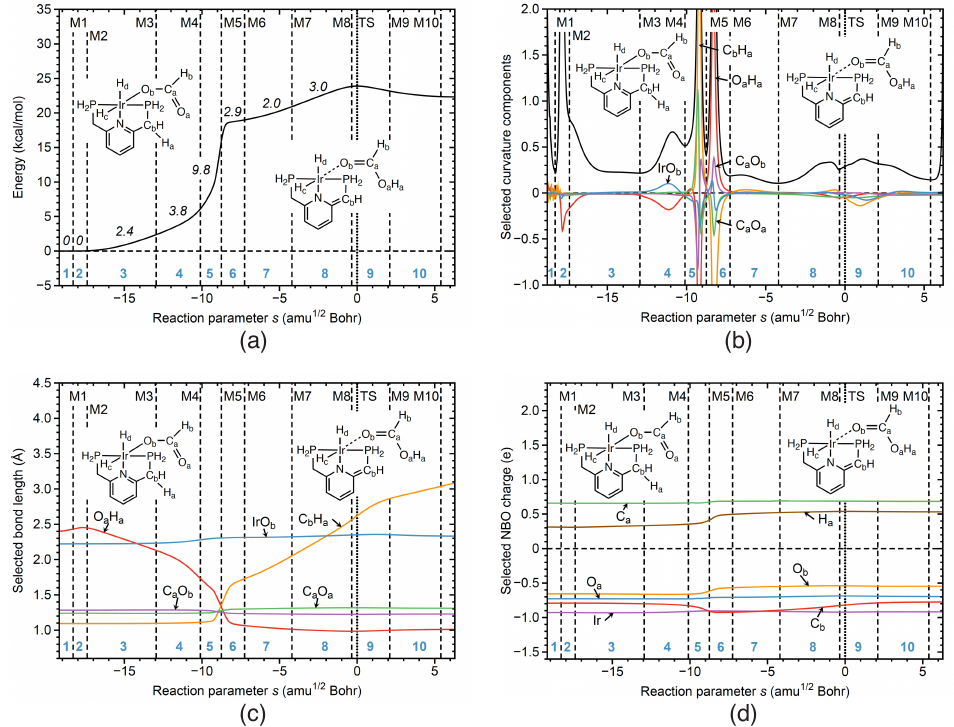
Figure 6. Properties of reaction R2 of the catalytic cycle along the reaction path. ( a ) Energy profile, energy contributions of each reaction phase to the activation energy are indicated by italic numbers; ( b ) decomposition of the reaction curvature into selected components; ( c ) change of selected bond lengths along s ; ( d ) change of selected NBO atomic charges along s . Positions of the curvature minima are shown as dashed vertical lines and are labeled as M1, M2, and so on. The position of the TS is indicated by a dotted line. Reaction phases are indicated by blue numbers. B3LYP/6- 31G(d,p)/SDD(Ir) level of